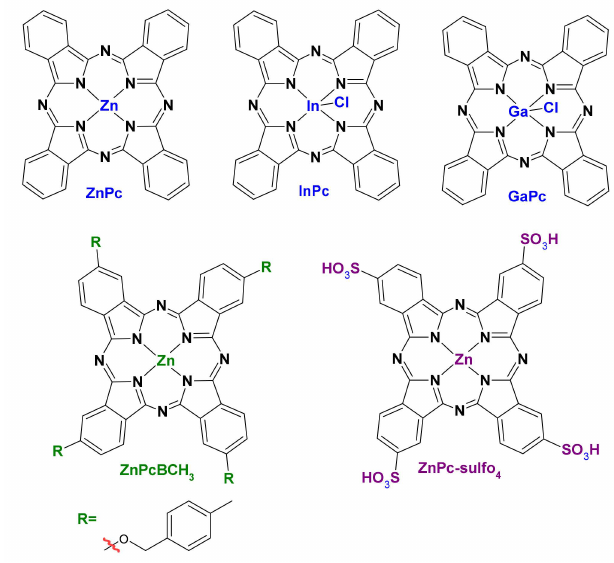
Scheme 6. Structures of ZnPc, InPc, and